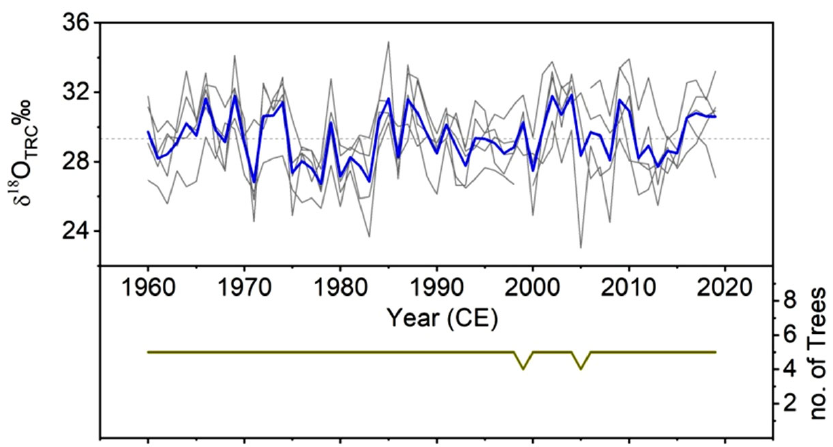
Figure 4. The 60 years (1960–2019 CE) mean tree ‐ ring δ 18 O chronology (blue line) of five trees (in the grey background) and the overall mean value of the tree ‐ ring δ 18 O chronology (horizontal grey dotted line) and the number of trees included in the chronology are presented in the lower panel.